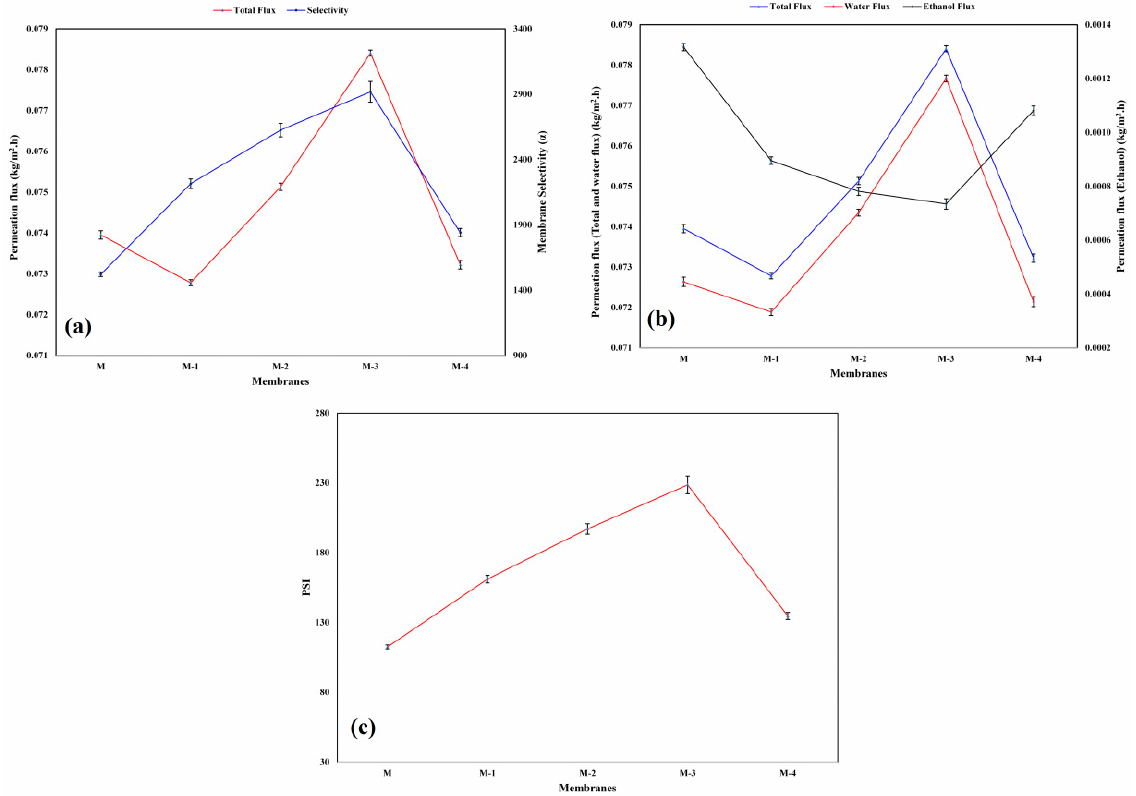
Figure 6. ( a ) Deviation in total permeation flux and separation selectivity with different mass% of Ge; ( b ) deviation in total permeation flux and permeation fluxes of water and ethanol at 30 °C; ( c ) effect of Ge content on pervaporation separation index (PSI) at 30 °C.